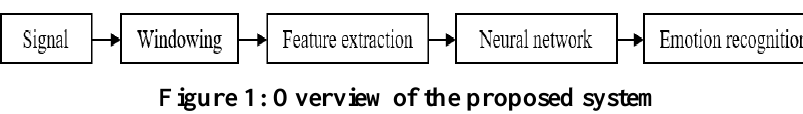
Figure 1: Overview of the proposed